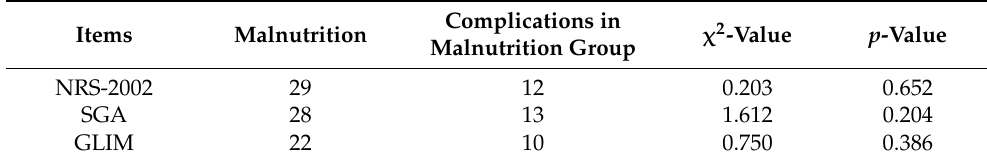
Table 6. Chi-square test results for the correlation between nutritional status and